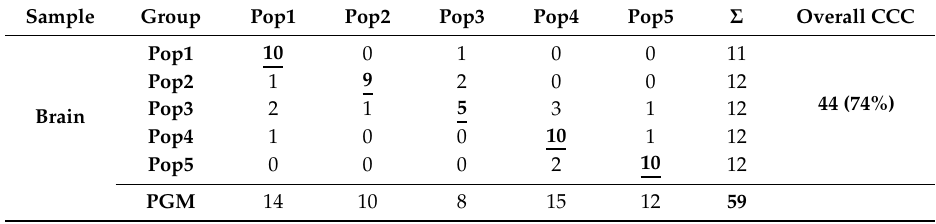
Table 7. Results of population level classifications using MSPP. In the confusion matrix the actual and predicted groups are presented in rows and in columns, respectively. The correctly classified cases (cid:80) (CCC) are indicated by bold letter type and underlined. : number of individuals per